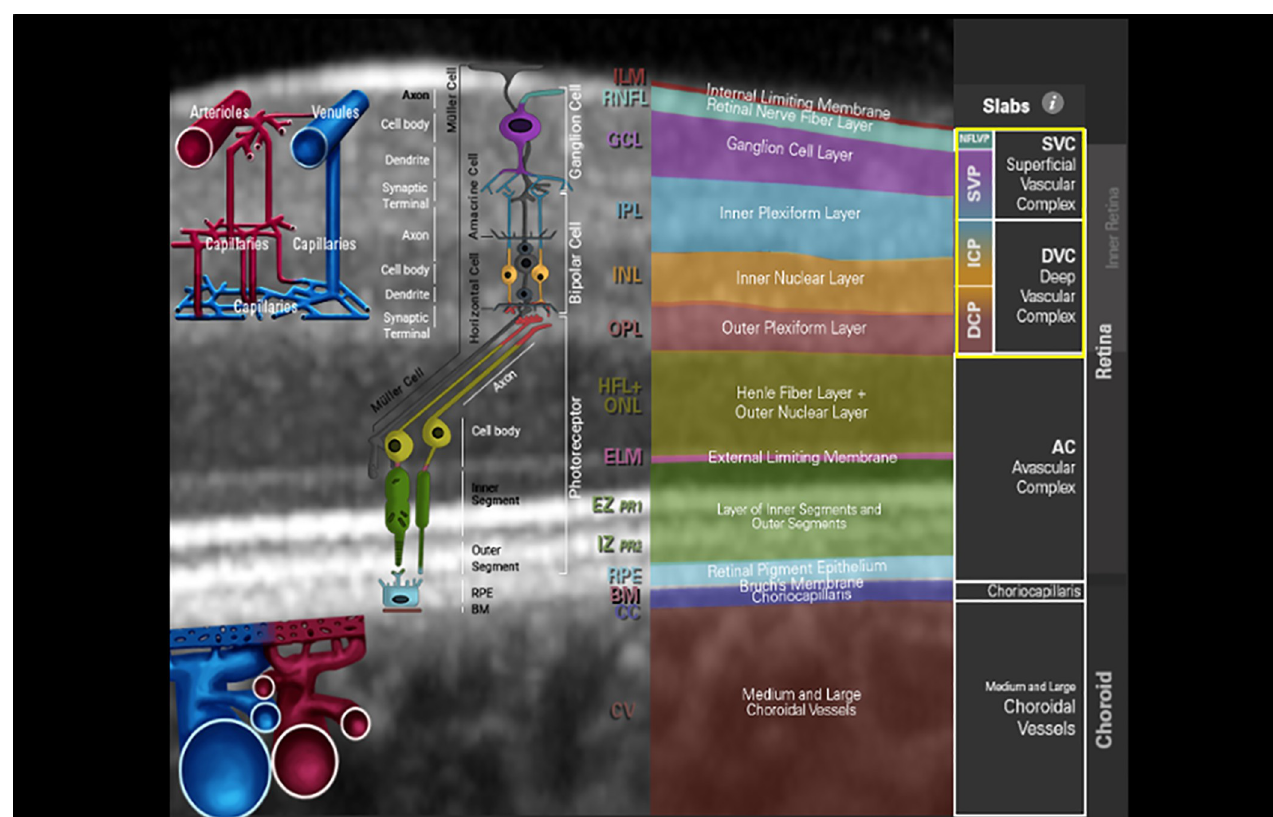
Fig 1. Structure OCT detail of the macula with the corresponding structural OCT layers and OCT-A slabs of the inner retina (yellow box). Image courtesy by Heidelberg Engineering, Heidelberg, Germany.